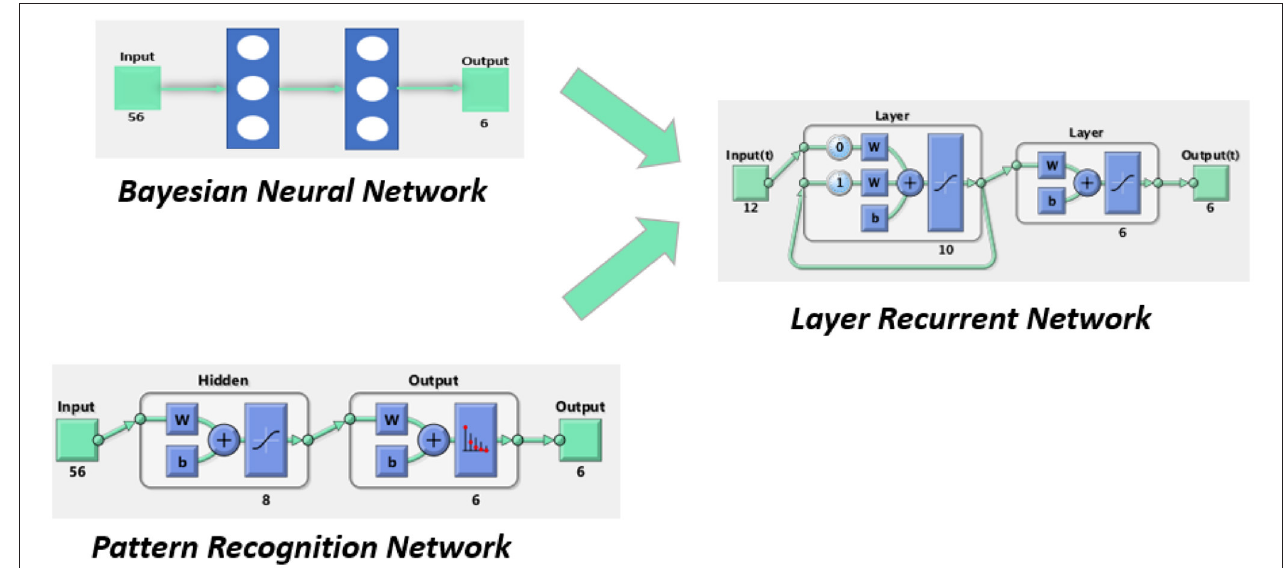
FIGURE 4 | Proposed neural network